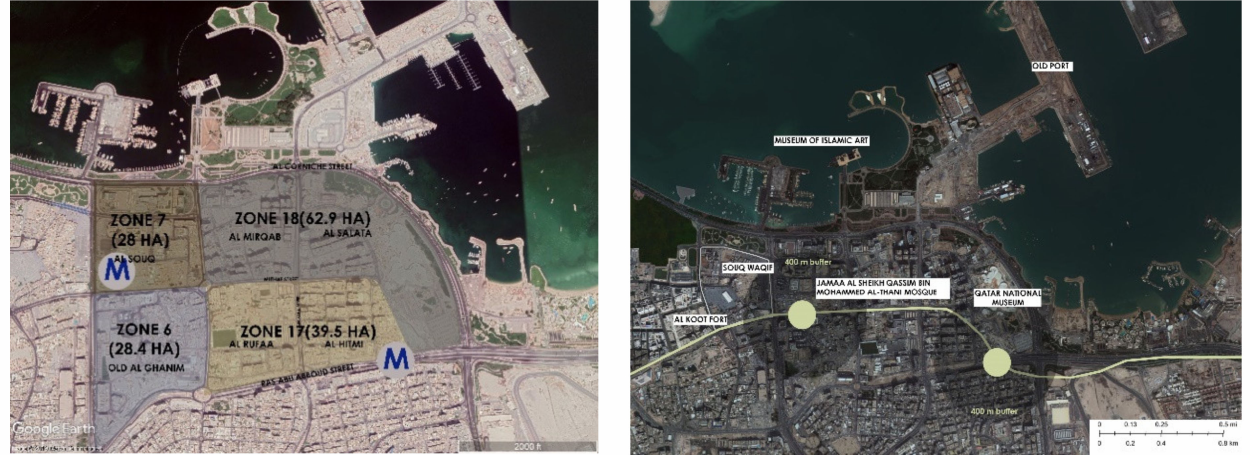
Figure 2. Site context and Metro stations in the study